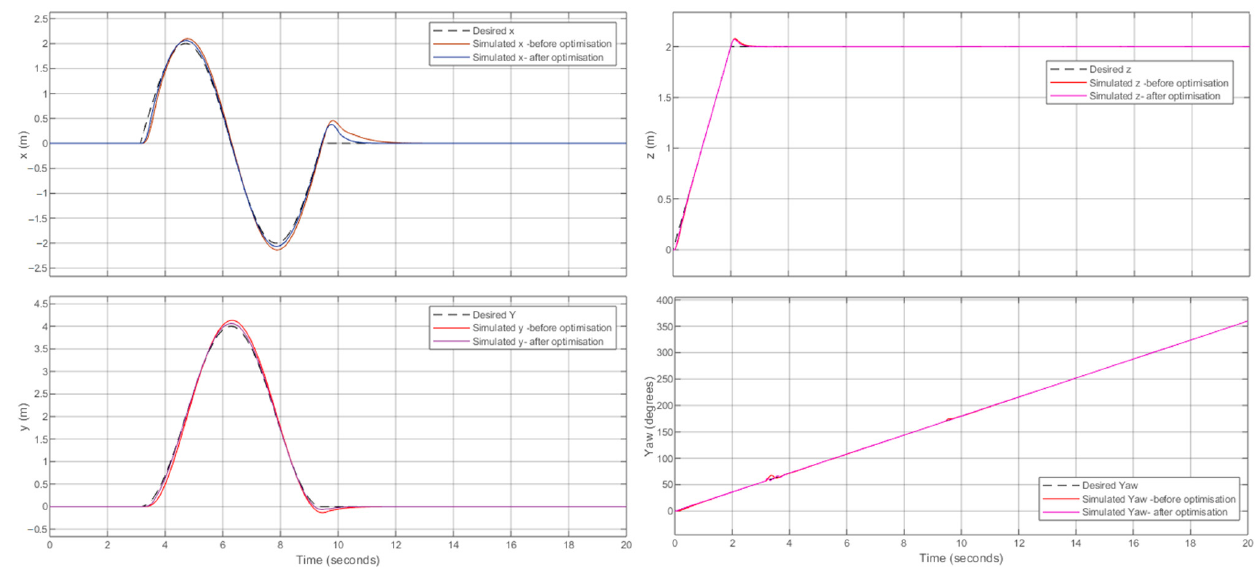
Figure 9. Test trajectory in the 3D coordinate system.